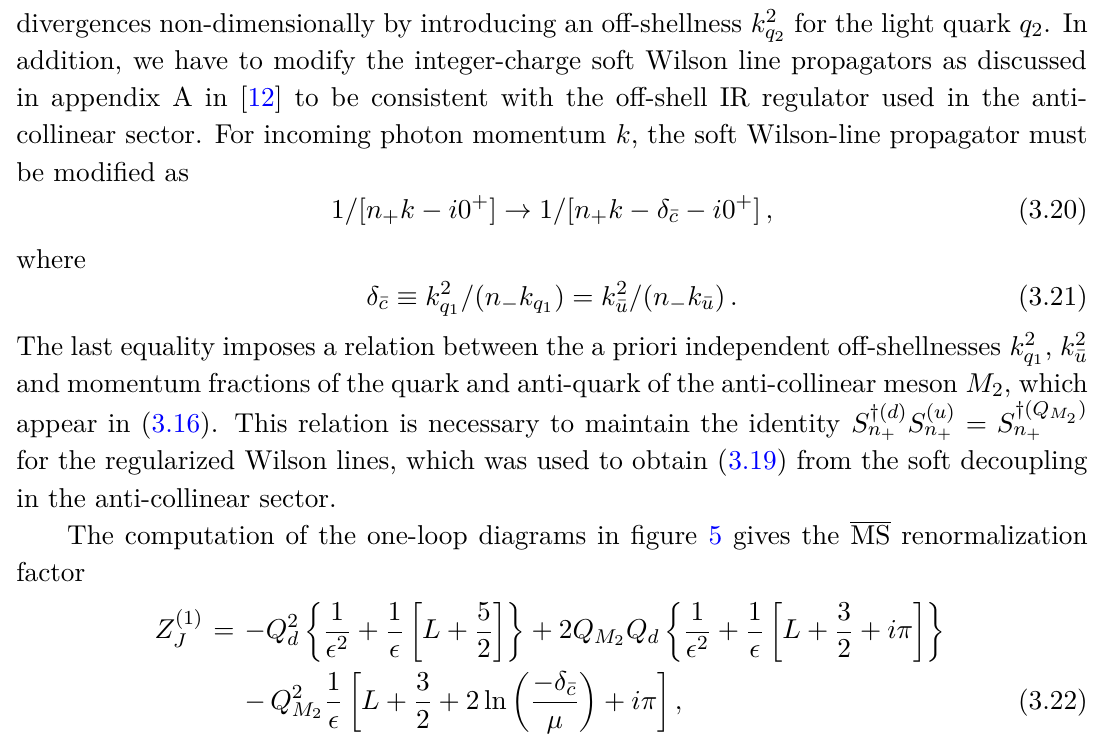
. Field-renormalization diagrams are not +